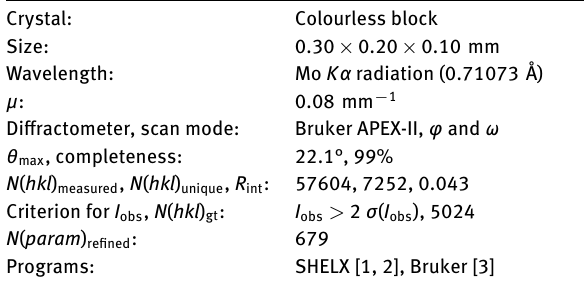
Table 1: Data collection and